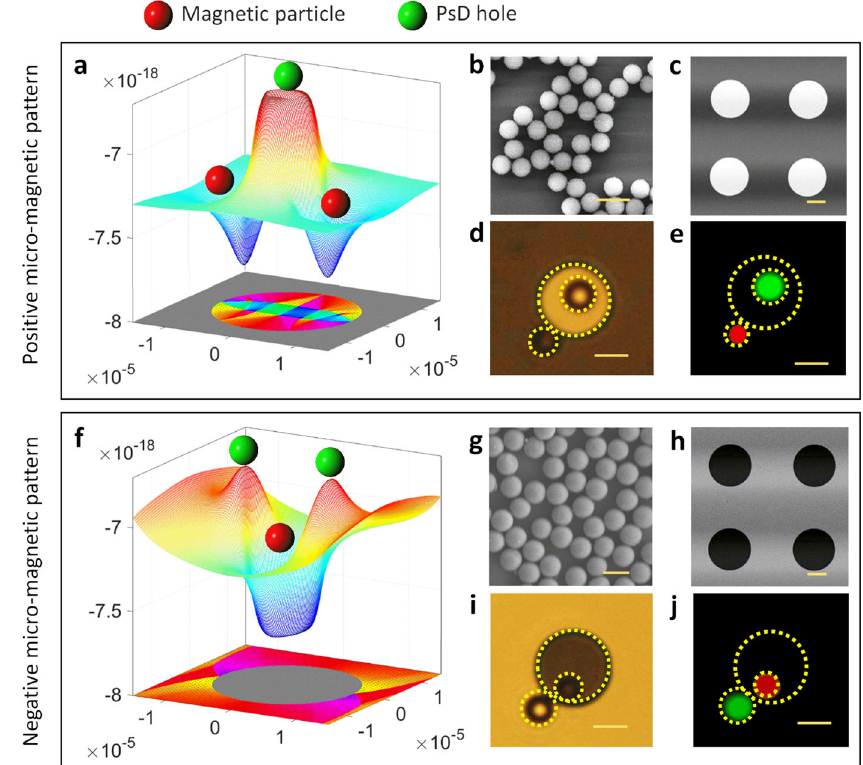
Fig. 3 Magnetic particles and PsD holes trapping locations on positive and negative micro-magnetic patterns. a Magnetostatic potential energy landscape over a full-disk positive micro-magnetic pattern predicts the trapping locations of magnetic and PsD holes. The magnetic domains simulated for the positive micro-magnetic pattern under 2 mT. b , c TEM and SEM images of 2.8 µ m magnetic particles and positive magnetic patterns, respectively. d , e Visualization of optical and fl uorescent images of trapped magnetic particles and PsD holes, respectively, on a full-disk positive magnetic pattern. f Magnetostatic potential energy landscape over the full-disk negative micro-magnetic pattern predicts the trapping locations of magnetic particles and PsD holes. The magnetic domains simulated for the negative magnetic pattern under 2 mT. g , h TEM and SEM images of 3.57 µ m PsD holes and negative magnetic pattern, respectively. i , j Visualization of optical and fl uorescent images of trapped magnetic particles and PsD holes, respectively, on a negative micro-magnetic pattern. Scale bar: 5 µ m.